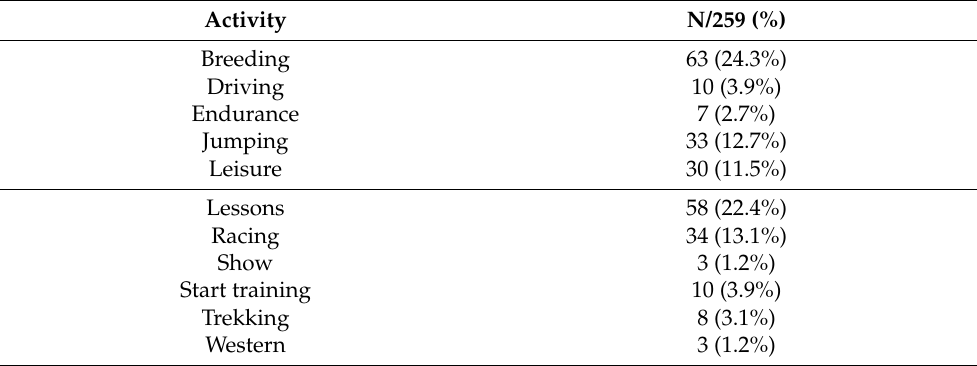
Table 1. Number (N) and prevalence (%) of horses included according to the type of activity.